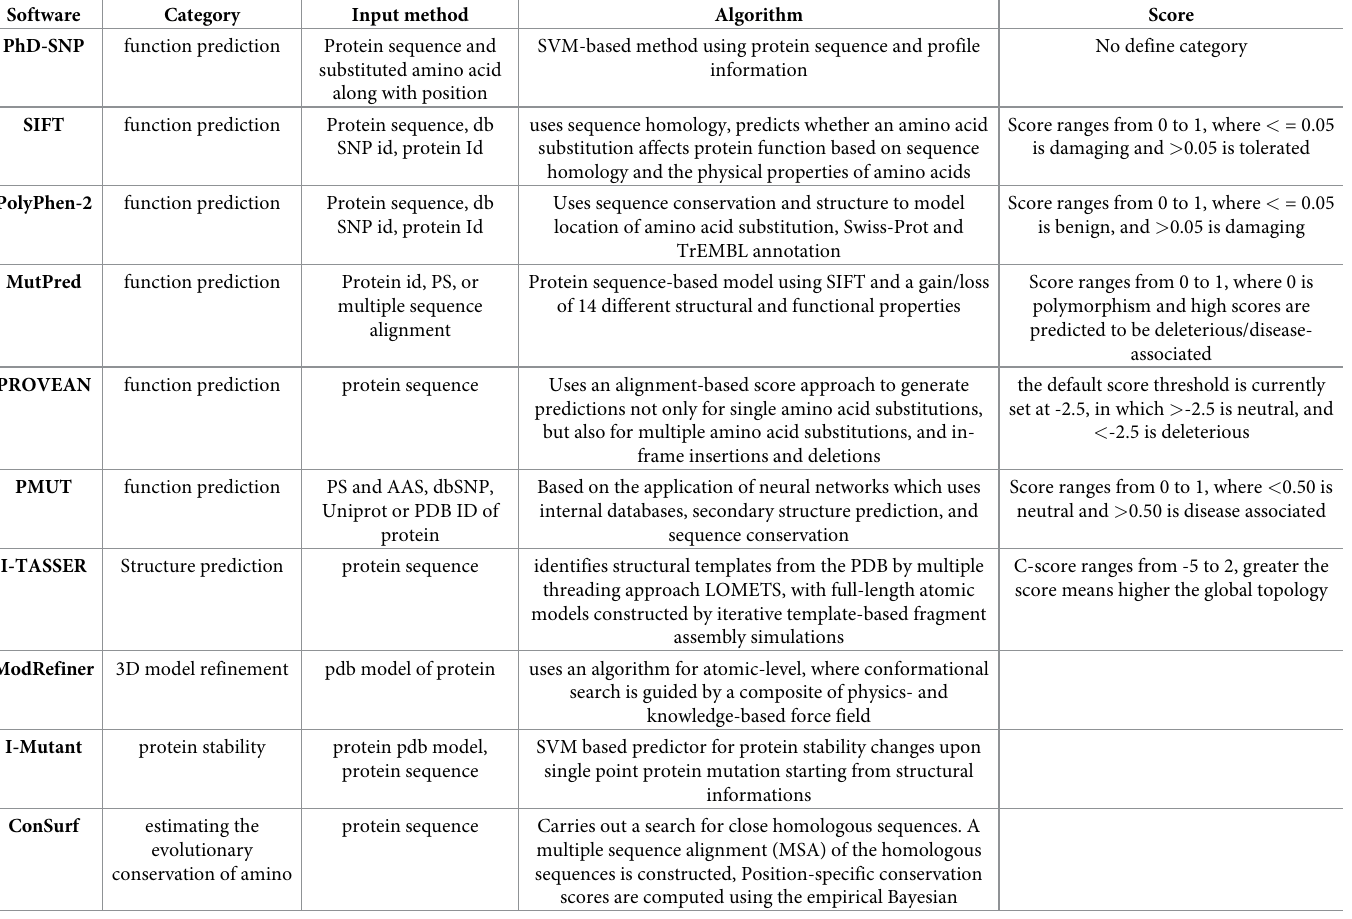
Table 1. Summary of all software used to find out harmful missense SNPs and their impact on CD-209